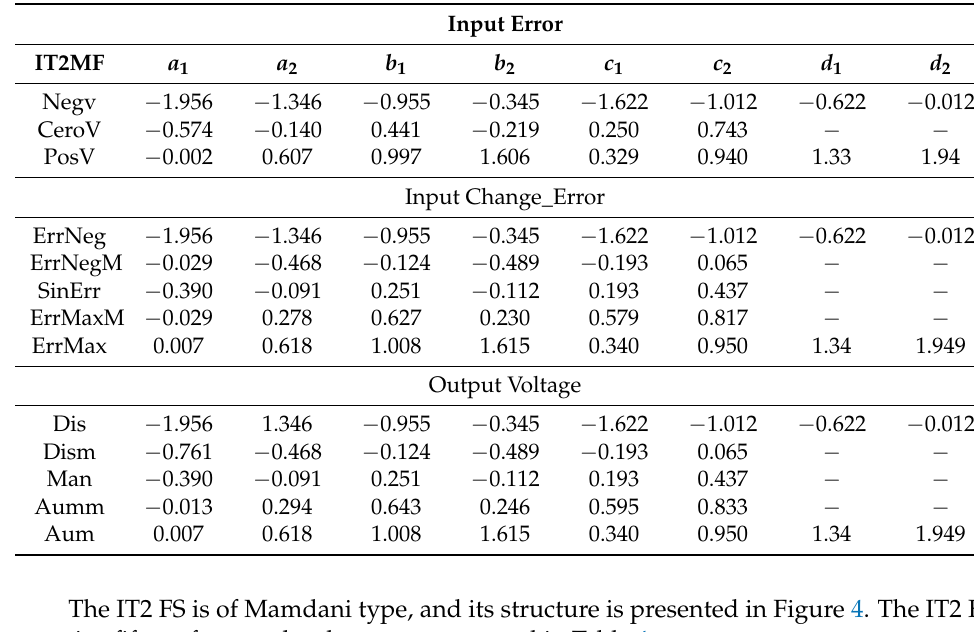
Table 3. IT2 FSs membership functions.